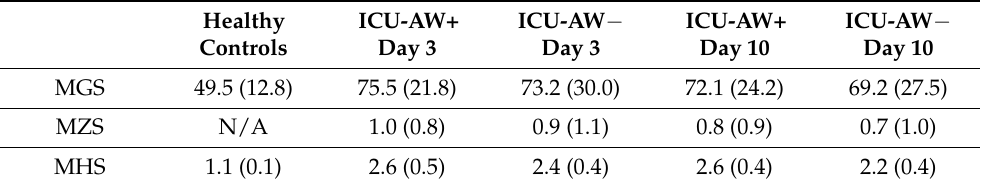
Table 3. Global muscle echogenicity parameters. Data presented as mean (standard deviation). The results are rounded to the first decimal place. ICU-AW: intensive care unit-acquired weakness. MGS: global mean greyscale score. MHS: global mean Heckmatt score. MZS: global mean z-score. N/A: data not